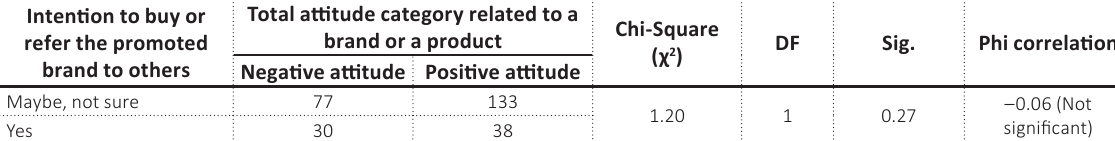
Table 8. Chi-square and Phi coefficient for intention to buy and total attitude towards the